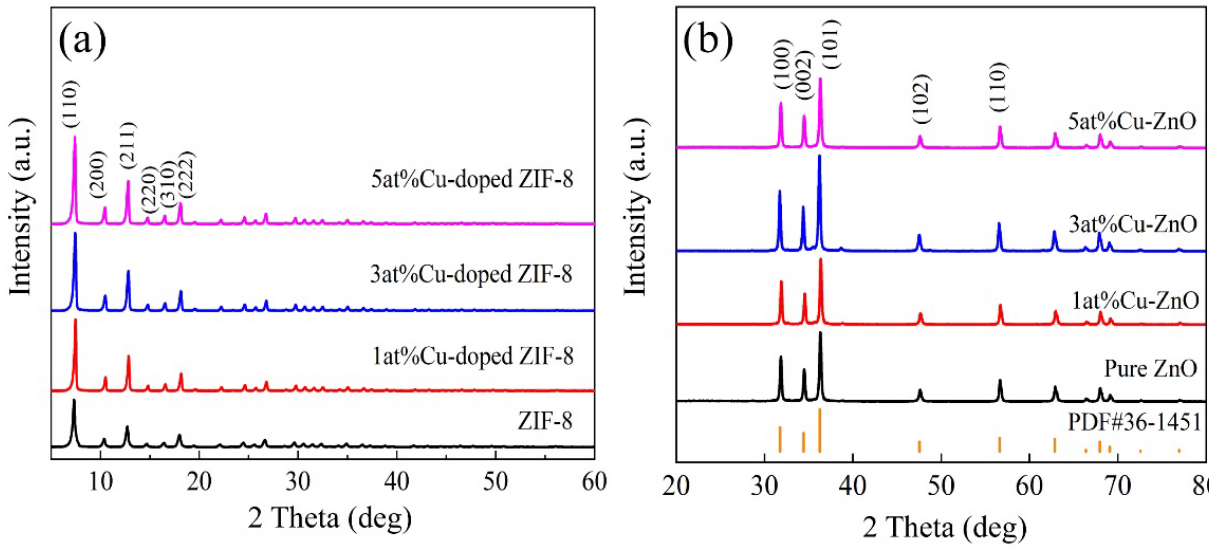
Figure 2. XRD patterns of the samples: ( a ) ZIF-8 and Cu-doped ZIF-8; ( b ) MOF-derived ZnO and Cu-doped ZnO nanocages.